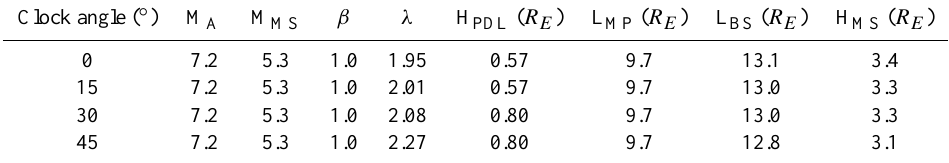
Fig. 8. The flow speed, the plasma den- sity, the magnetic field magnitude, and the N/B ratio along the Sun-Earth line in Fig. 7. The other formats of this fig- ure are the same as those in Fig. 4.